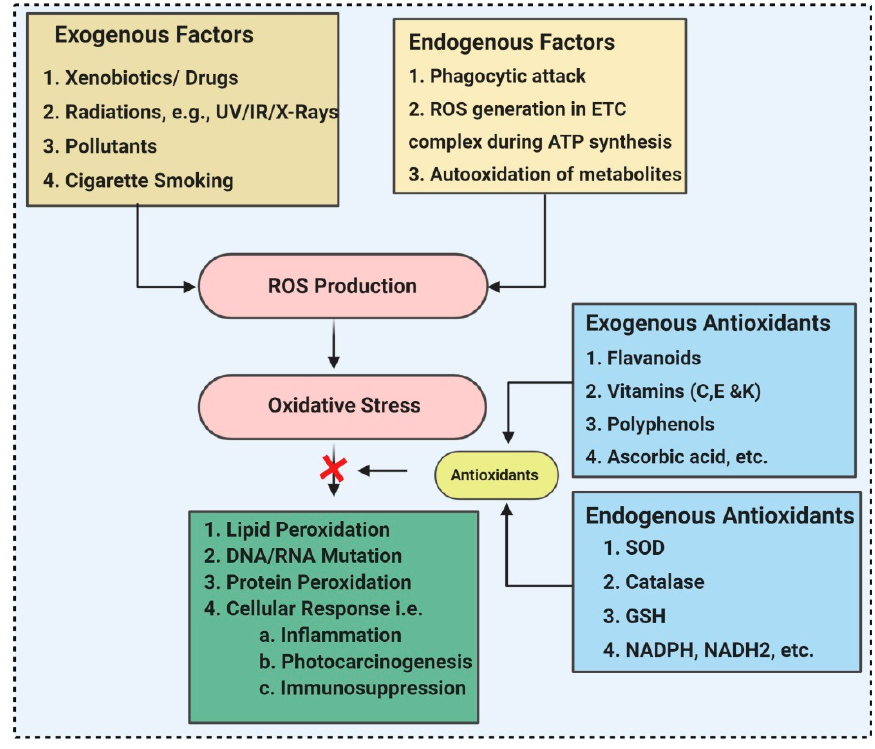
Figure 1. Various sources of oxidative stress and antioxidants